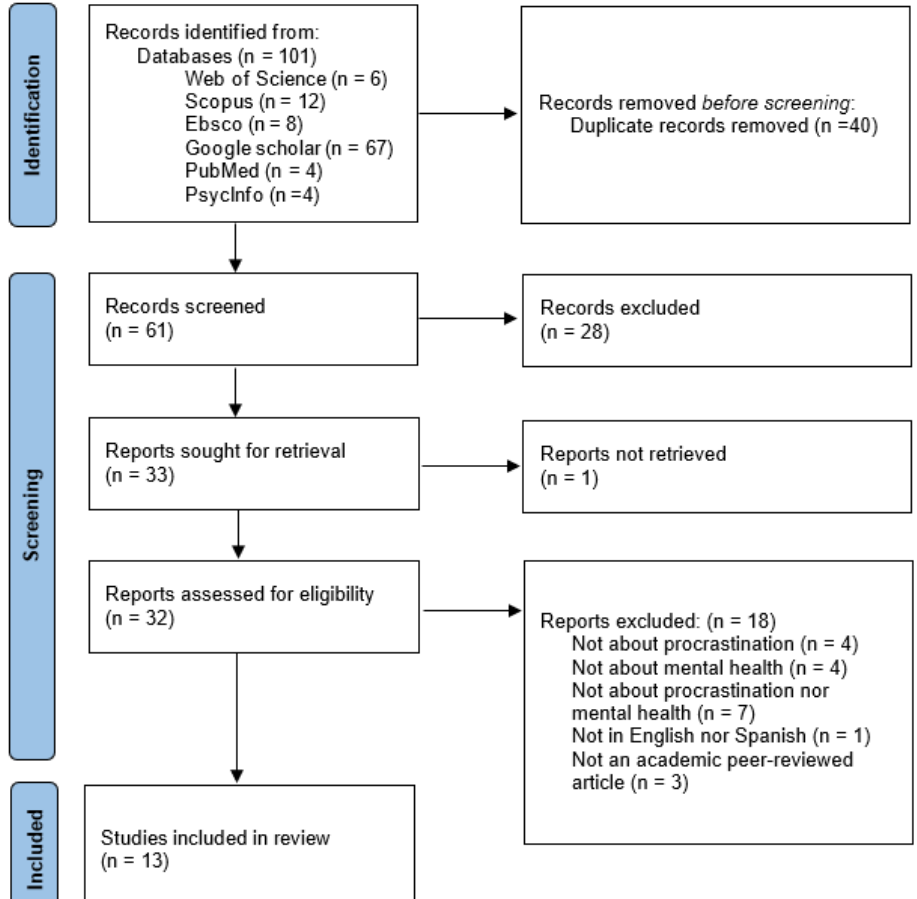
Figure 1. PRISMA flow diagram for source of evidence selection [36] .